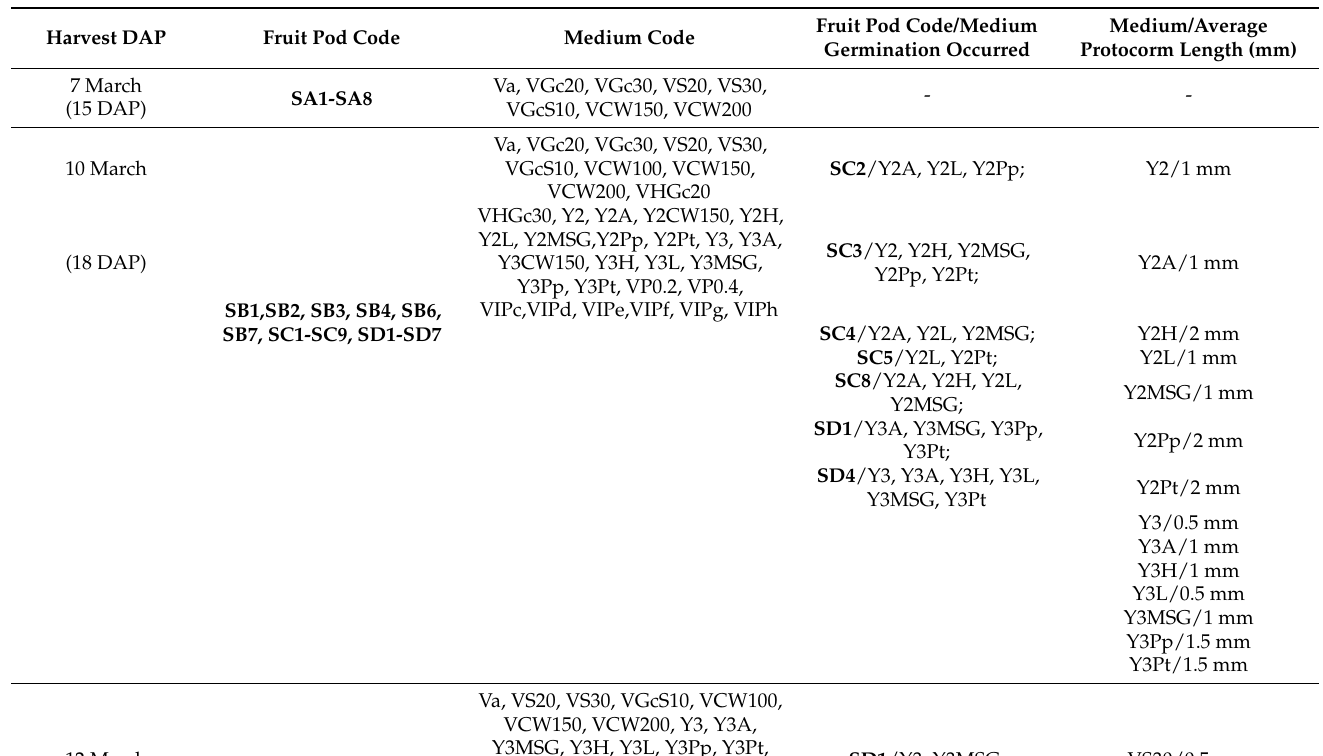
Table 1. Effect of carbohydrate, protein, and organic additives tested for germination of G. elata seeds harvested at different days after pollination (DAP) and cultured for one